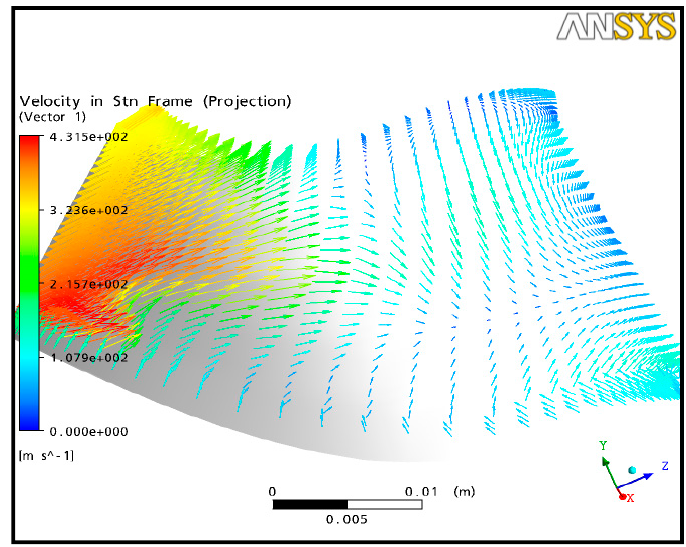
Figure 13. The absolute velocity at the mean meridian plane.